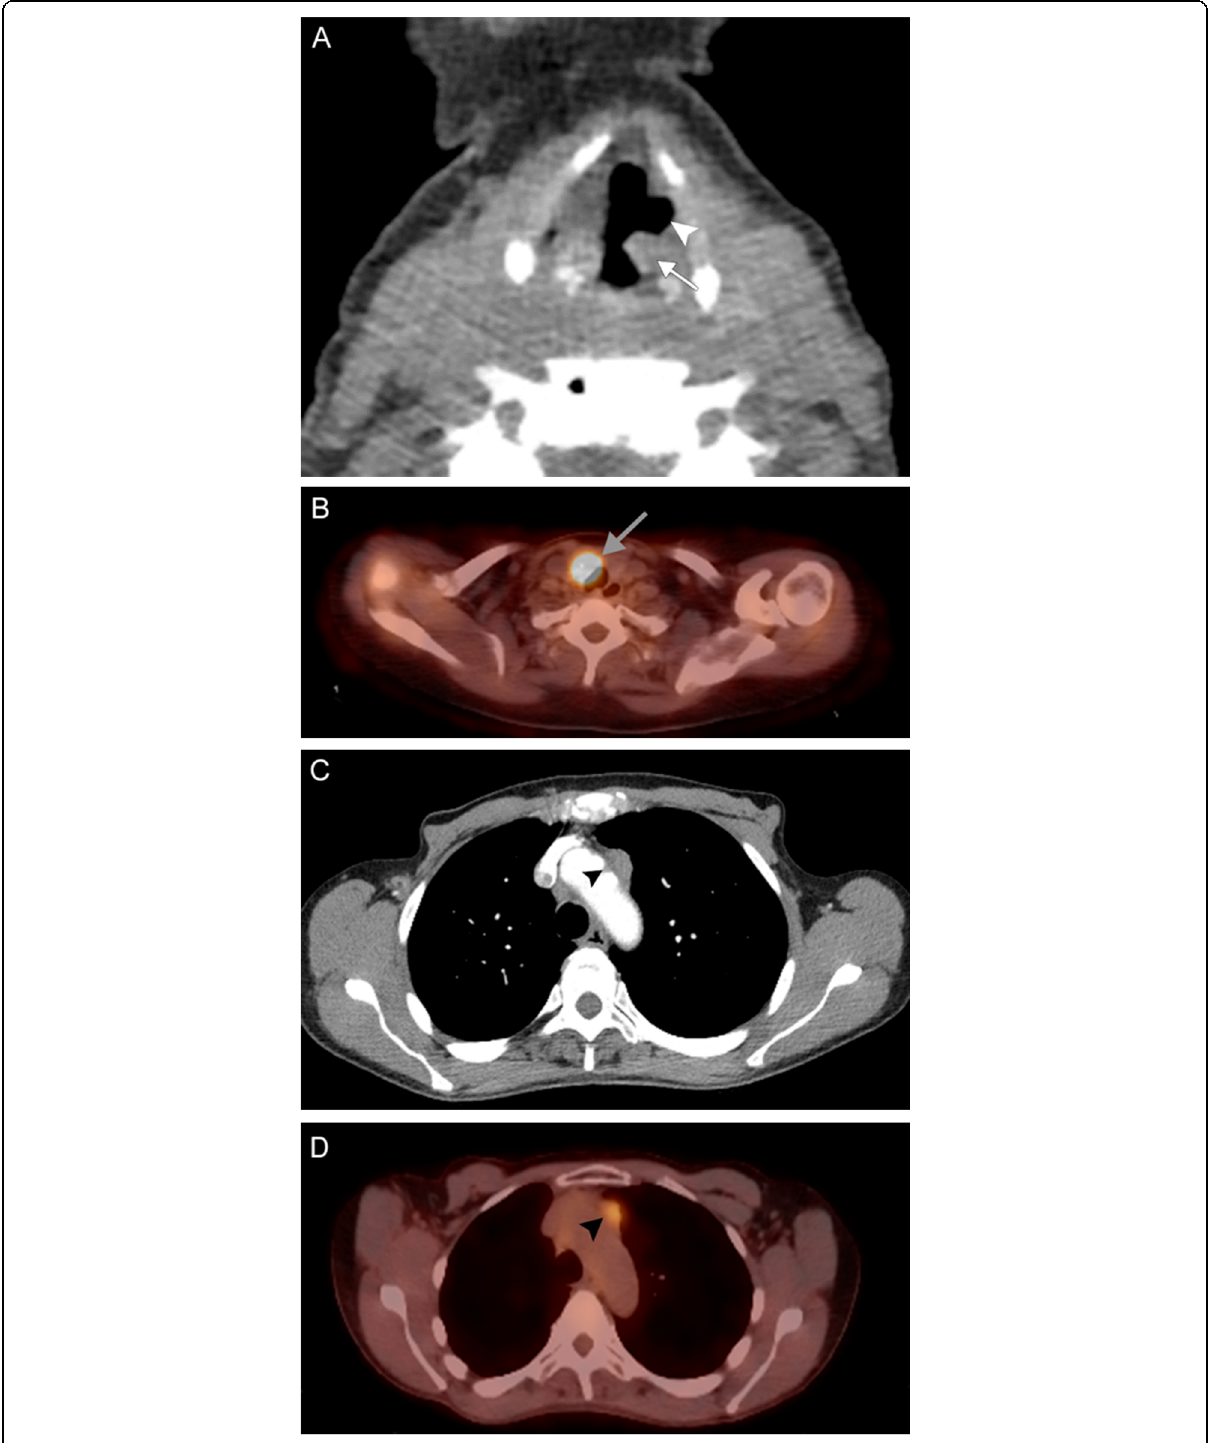
Fig. 20 Metastatic mediastinal lymphadenopathy. A 59-year-old woman with right breast cancer status post chemoradiation completed 5 years prior presents with rapidly progressive hoarseness. An axial non-contrast CT image ( a ) demonstrates anteromedial rotation of the left posterior vocal fold and arytenoid cartilage (white arrow) with associated left-sided dilatation of the laryngeal ventricle (white arrowhead). Associated PET image ( b ) demonstrates compensatory FDG uptake in the contralateral vocal fold (gray arrow). Contrast-enhanced CT ( c ) and PET ( d ) images more inferiorly reveal hypermetabolic prevascular lymphadenopathy in the superior mediastinum (black arrowheads). Overall, these findings are consistent with left vocal cord paralysis due to compression of the left recurrent laryngeal nerve by a metastatic prevascular lymph